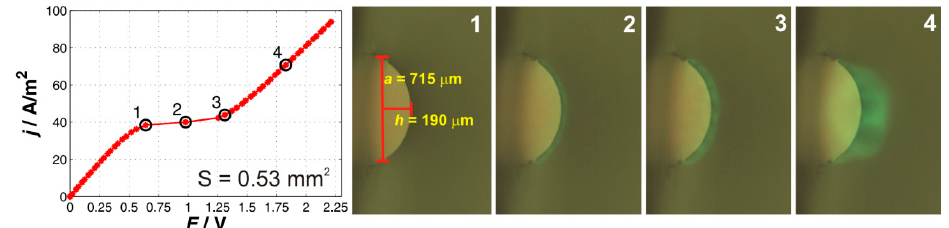
Figure 1. Current–voltage curve and a set of characteristic images for the one-particle membrane. The black circles on the current–voltage curve mark the current densities at which the depicted fluorescent images denoted as 1, 2, 3, and 4 were obtained.